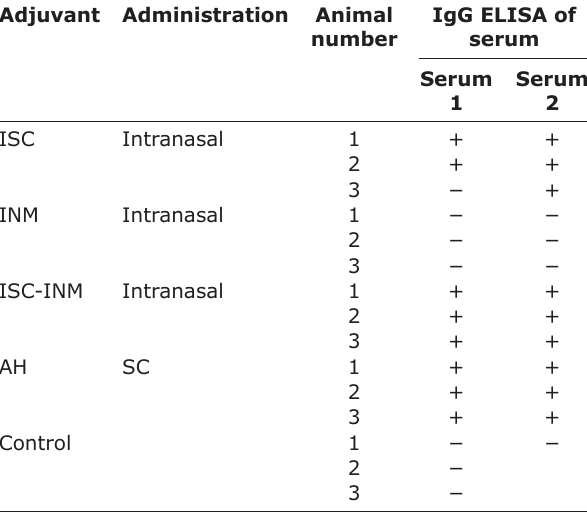
Table-2: IgG detection of anti-AIV H5N1 antibody detection in serum of mice following intranasal administration of inactivated AIV-H5N1 with ISCOMS and Inmunair as an